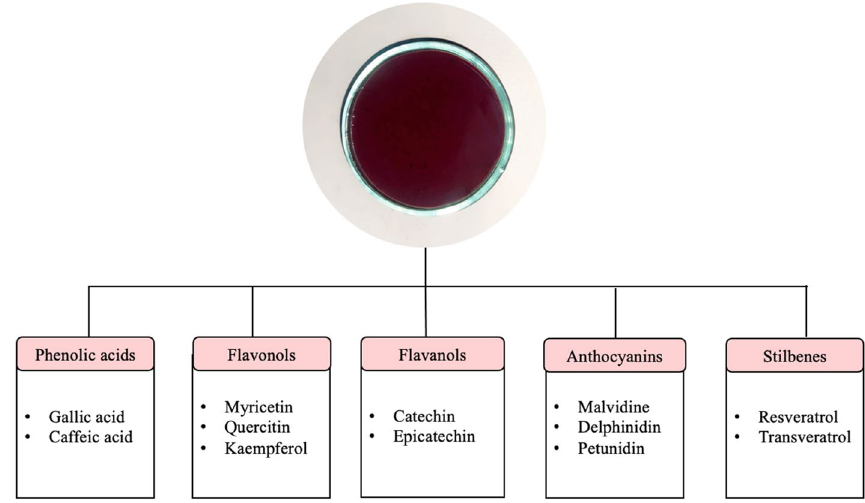
Fig. 1 Main bioactive compounds in wine lees. Source: Elaborated by the